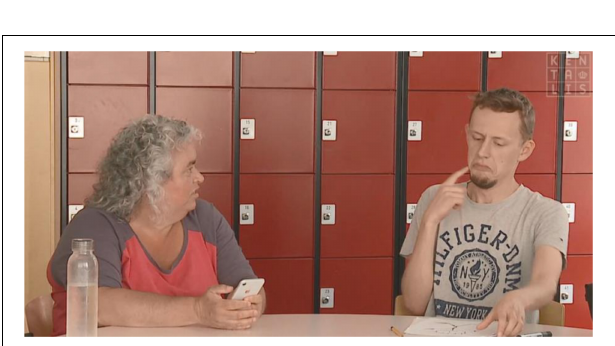
FIGURE 2 | Screenshot of the clip “white lie” in Dutch Sign